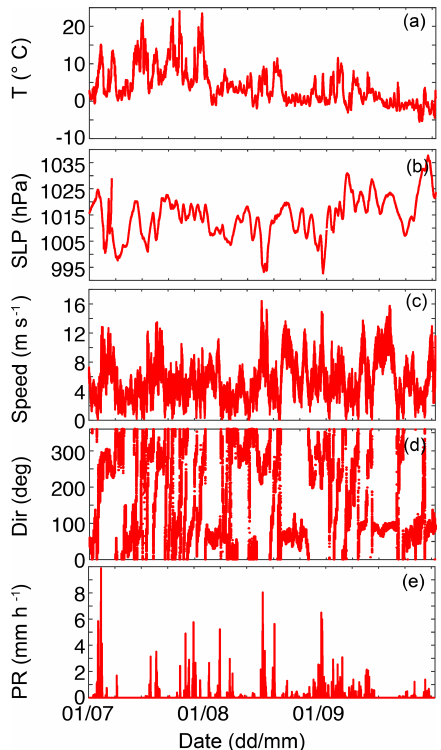
Figure 4. Surface meteorological conditions (1min resolution), as measured by instrumentation associated with the Oliktok Point AMF3 during POPEYE. From top to bottom are 2m air tempera- ture, sea level pressure, 10m wind speed, 10m wind direction and surface precipitation